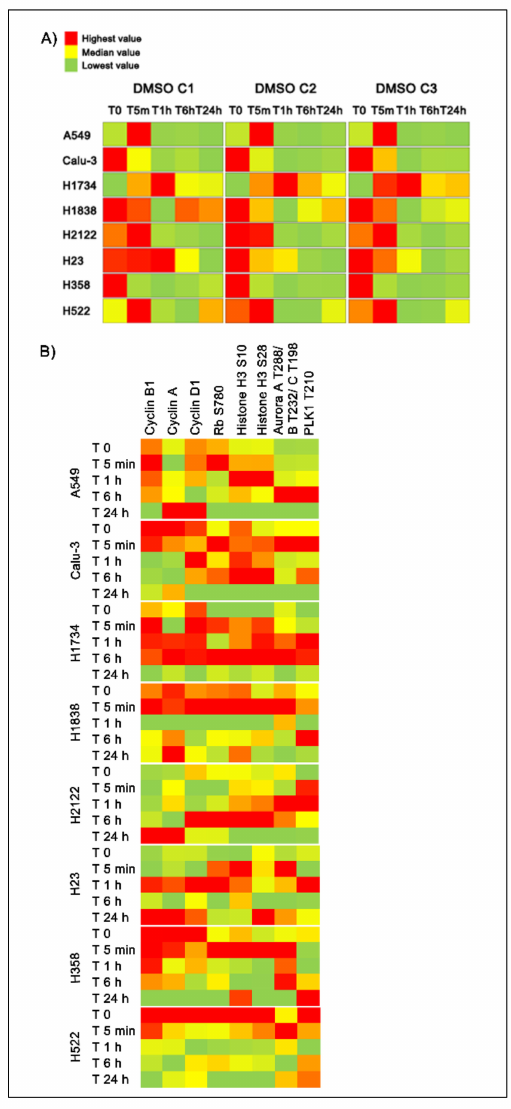
Figure 5. Heatmaps displaying dose- and time-dependent changes in ERK 1/2 activation measured as phosphorylation of the T202/Y204 residues (Panel A ) along with expression/activation levels of proteins involved in the cell cycle regulation (Panel B ). Heatmaps capture average values ( n = 3) across five timepoints for the three DMSO concentrations within each cell line using a red (highest) to green (lowest)